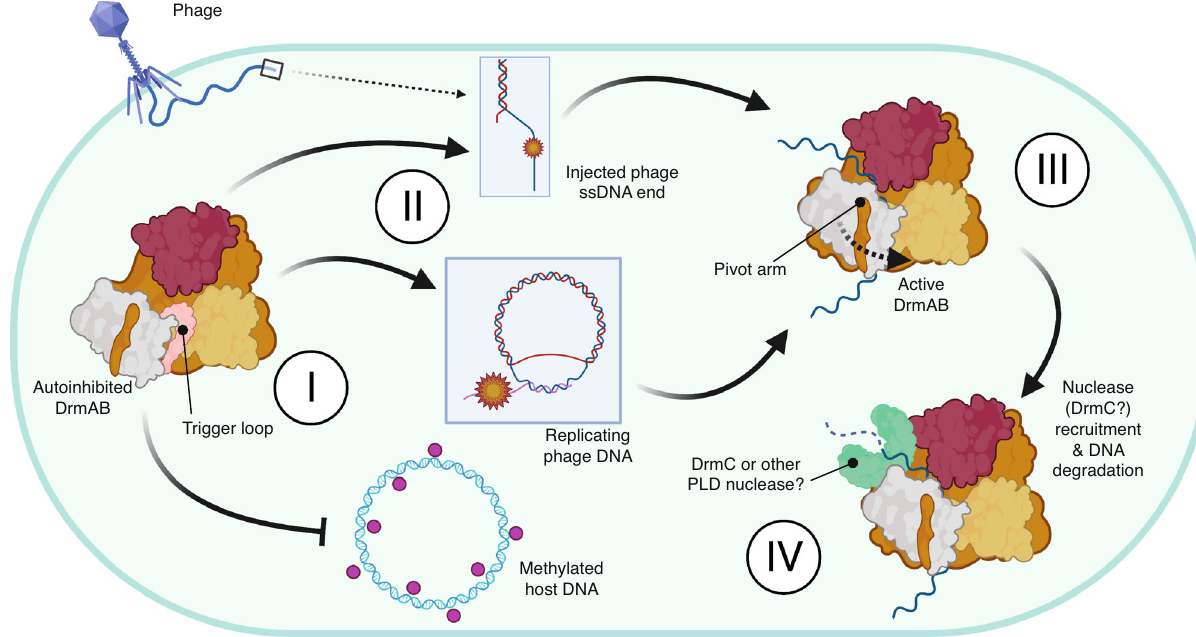
Fig. 5 Model for anti-phage surveillance by DISARM. I In the absence of phage infection, DrmAB complex is autoinhibited via TL. This allows the constitutive expression of the complex to enable rapid immune activation upon stimulus. II DISARM is recruited to single-stranded 5 ’ ovh DNA, which typically occur during initial phage DNA injection prior to genome circularization, or during rolling circle DNA replication. III Loading of ssDNA into DrmAB dislodges TL, resulting in a conformational change and DrmAB activation. IV Once DrmAB is active, DrmC or other nucleases may be recruited to degrade foreign DNA. DISARM may act to defend against phage at step III by loading onto phage DNA ends and physically blocking replication, and at step IV through recruiting a nuclease and degrading phage DNA. This cartoon was created with